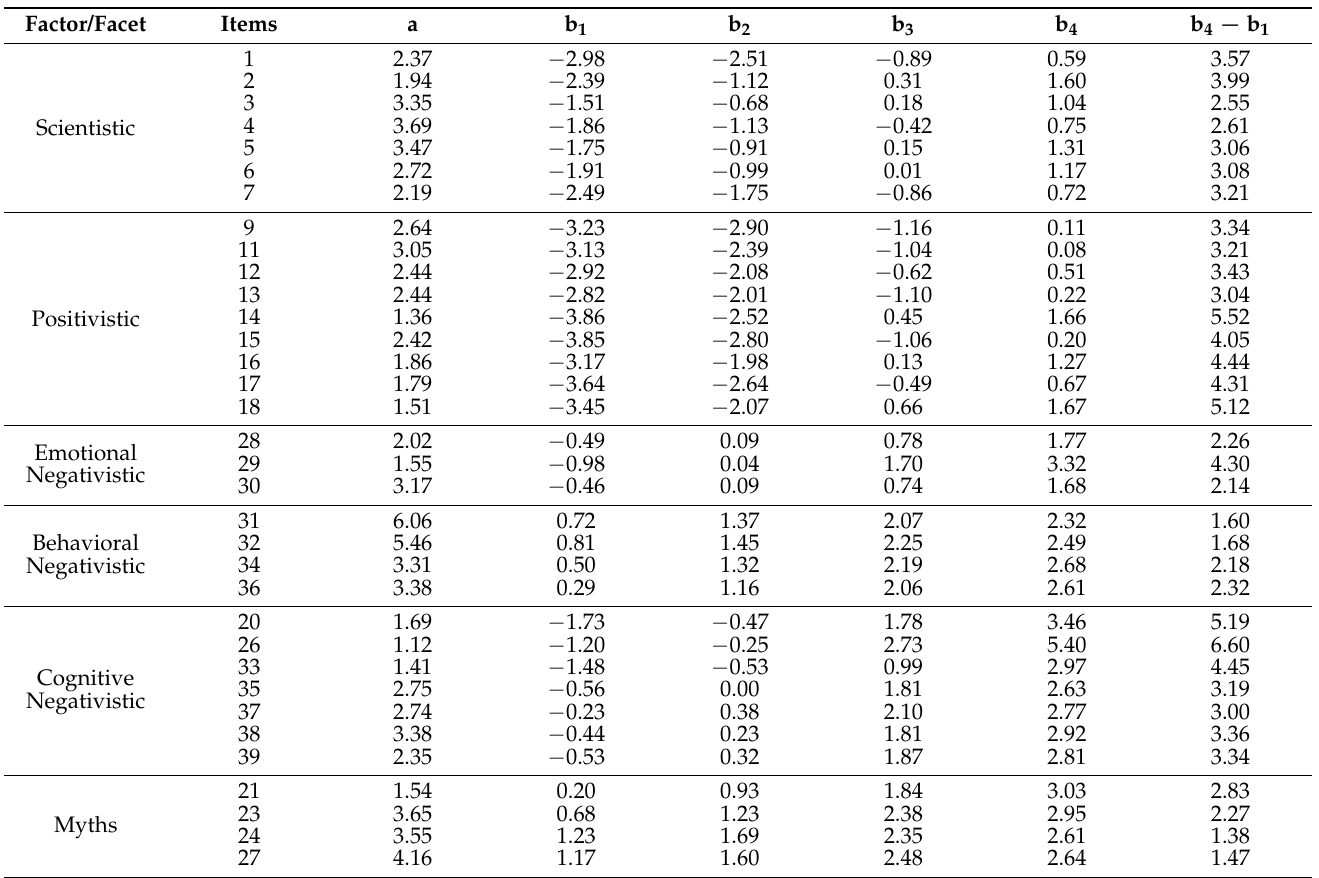
Table A4. Discrimination (a) and difficulty (b) parameters of the